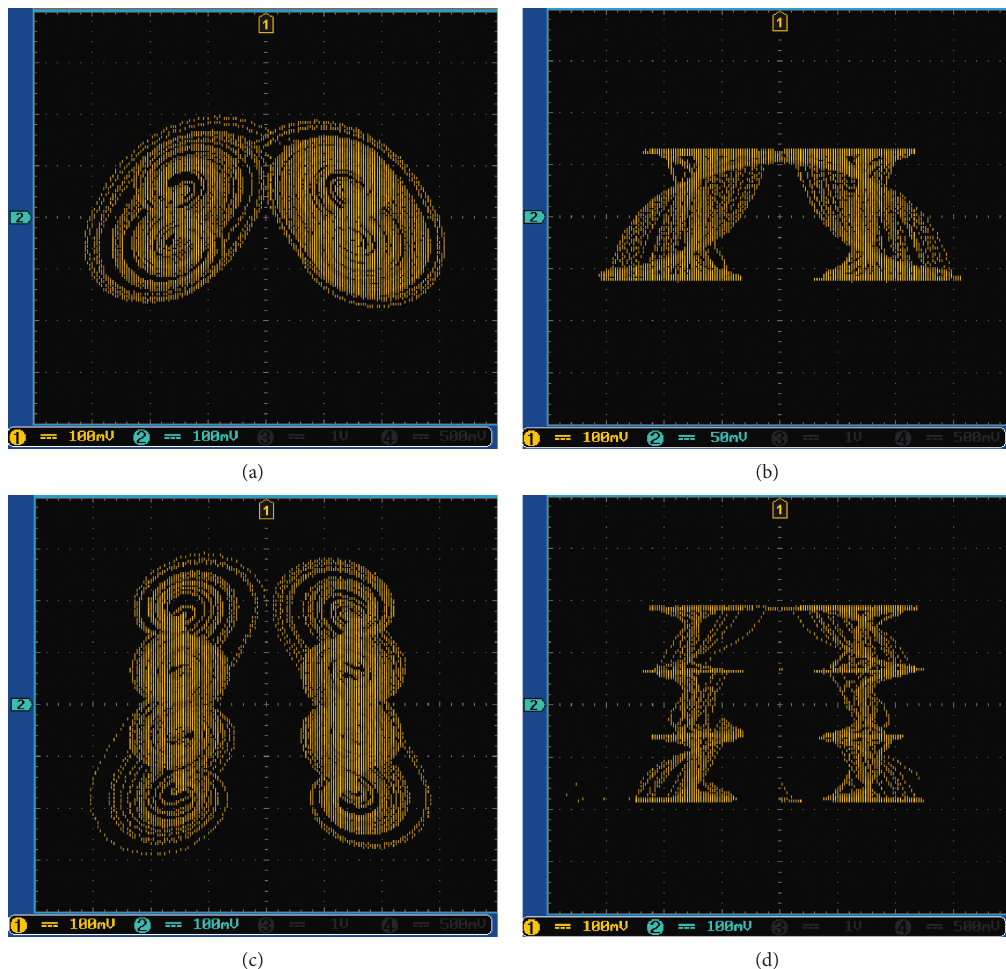
Figure 14: Phase portraits of chaotic system with n � 0 and n � 1 from the experimental results: (a) y versus z with n � 0, (b) y versus w with n � 0, (c) y versus z with n � 1, and (d) y versus w with n �